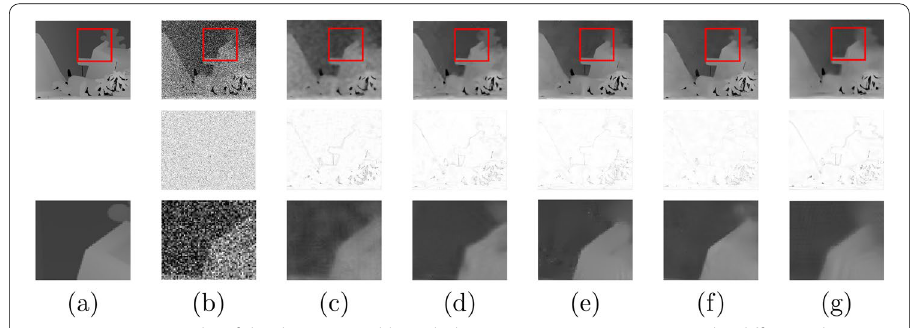
Fig. 7 Denoising results of depth image ( teddy ) with the noise variance σ = 50 [top], the difference between the original depth images and the filtered images [middle], and zoom-in image [bottom]. From the left ( a ) to right ( g ) are: the original image, the noisy image, the results obtained by NLM, BM3D, OGLR, ADnet and the proposed method respectively